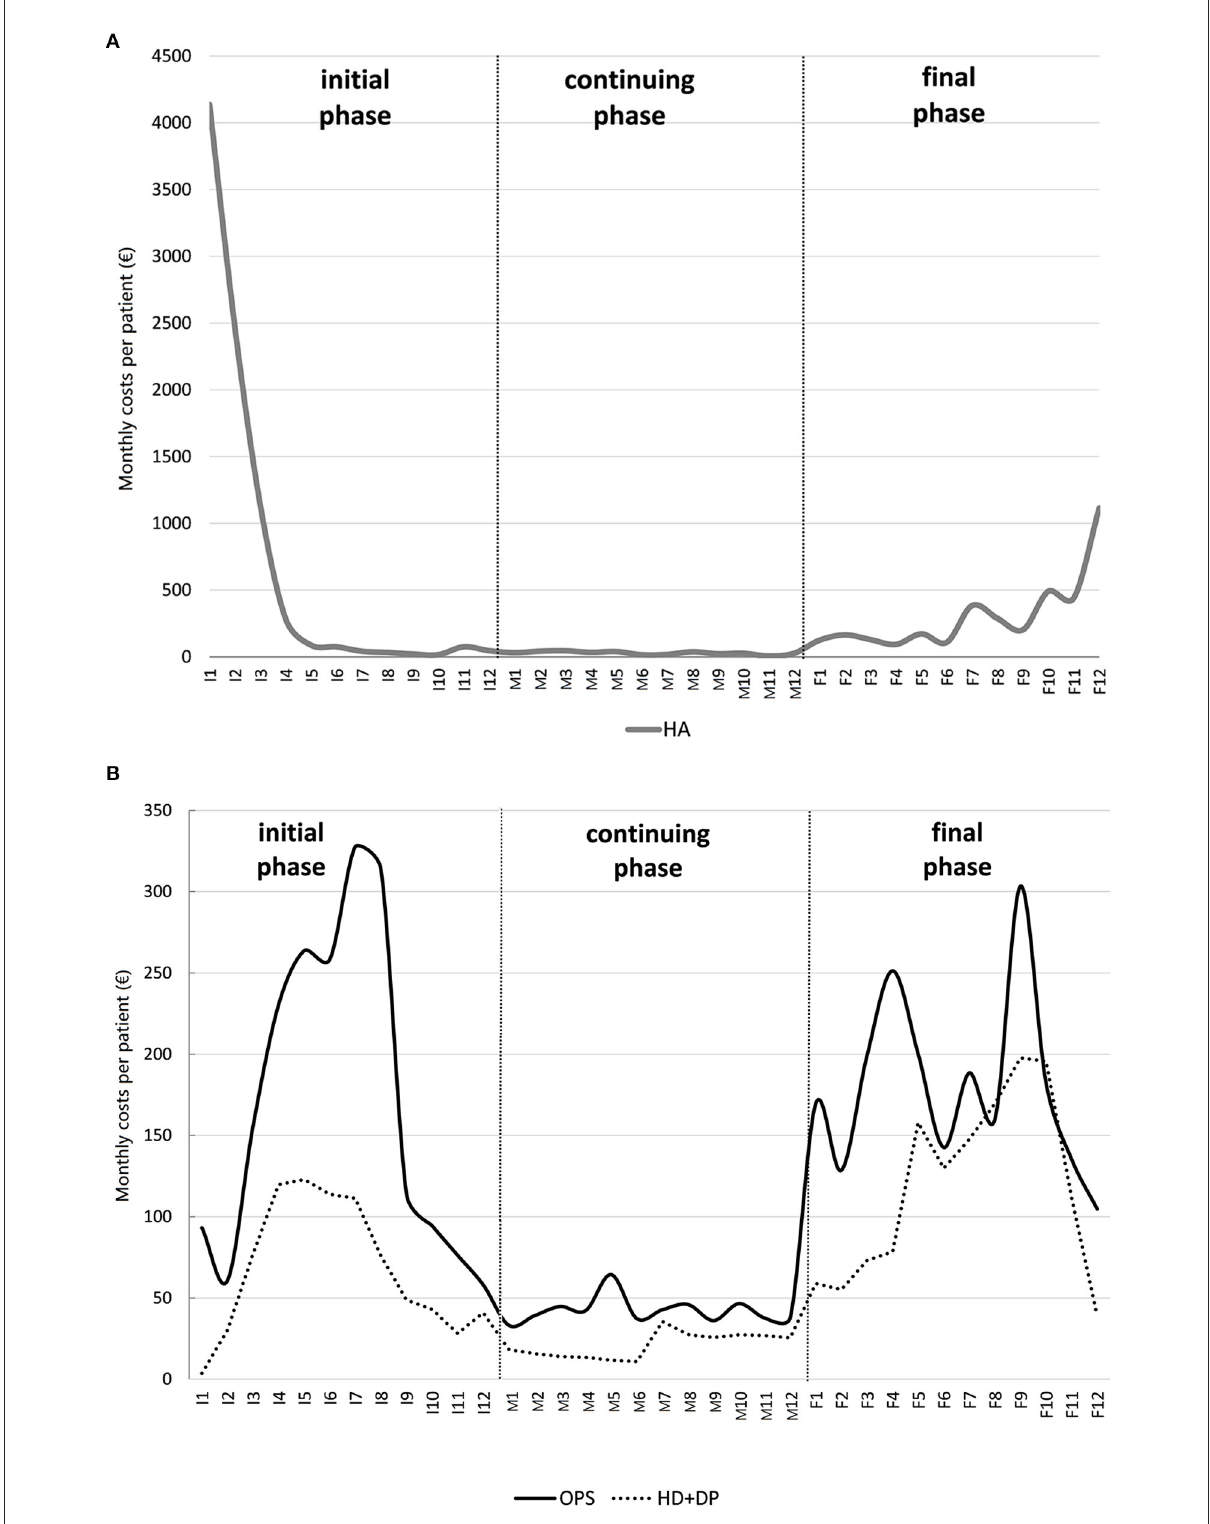
FIGURE3 Example of a colon cancer patient cost profile due to (A) hospitalisation and (B) outpatient services and drugs (hospital drugs and drug prescriptions